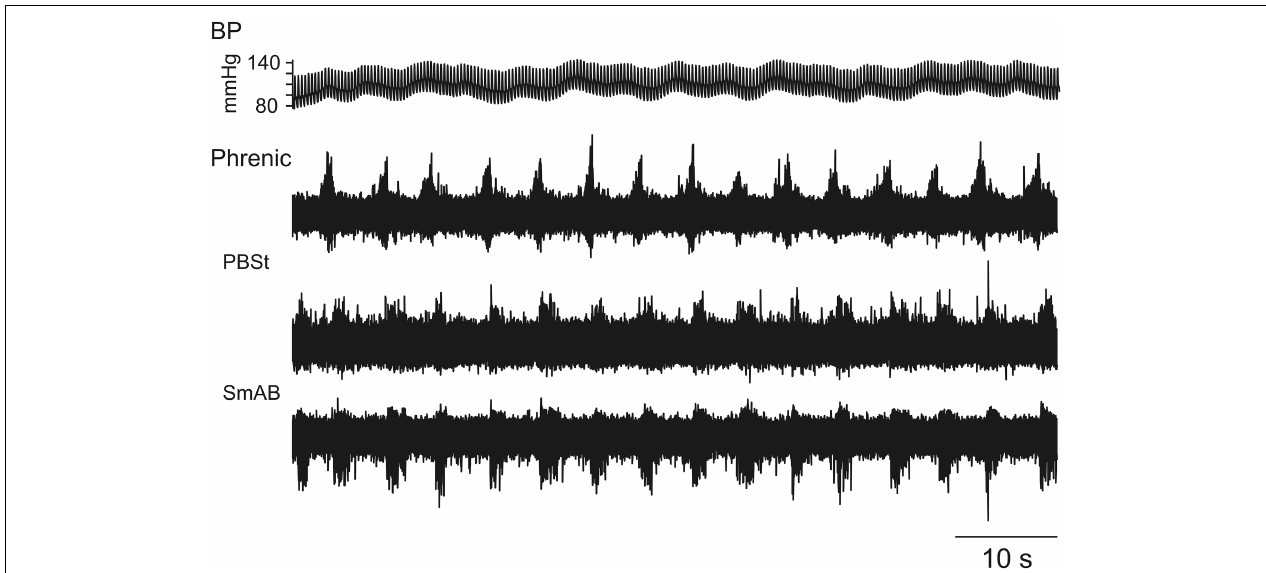
FIGURE 2 | Maintained post-inspiratory co-activation of hindlimb muscle nerves following every phrenic nerve discharge. In this case the maintained post-inspiratory co-activation of PBSt and SmAB occurred steadily in the absence of Mayer wave behavior.